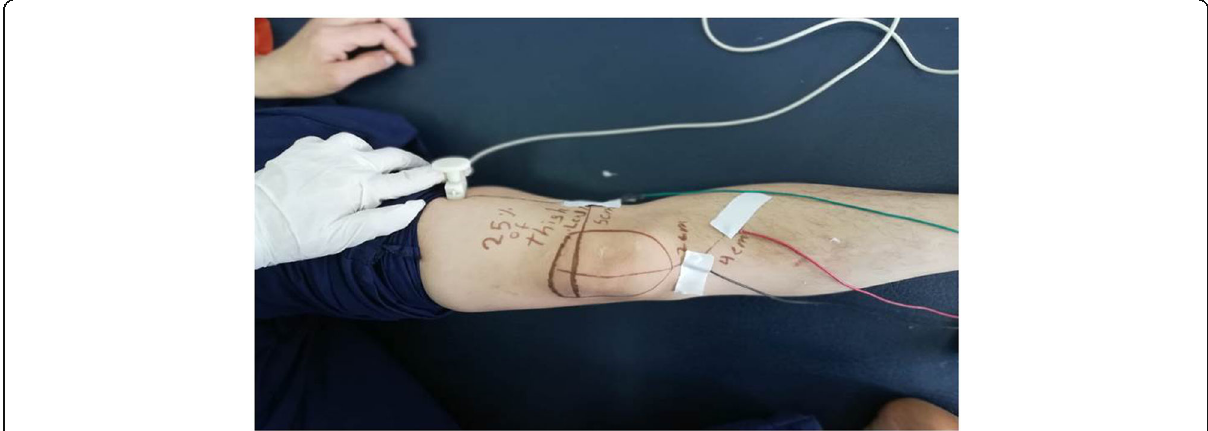
Fig. 3 Technique of NCS of infrapatellar nerve, performed in the department of Rheumatology and Rehabilitation by assessment of the sharing rheumatologist using NIHON KOHDEN